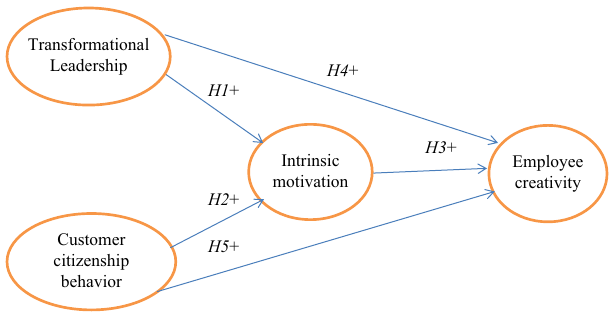
Figure 1. Theoretical model and